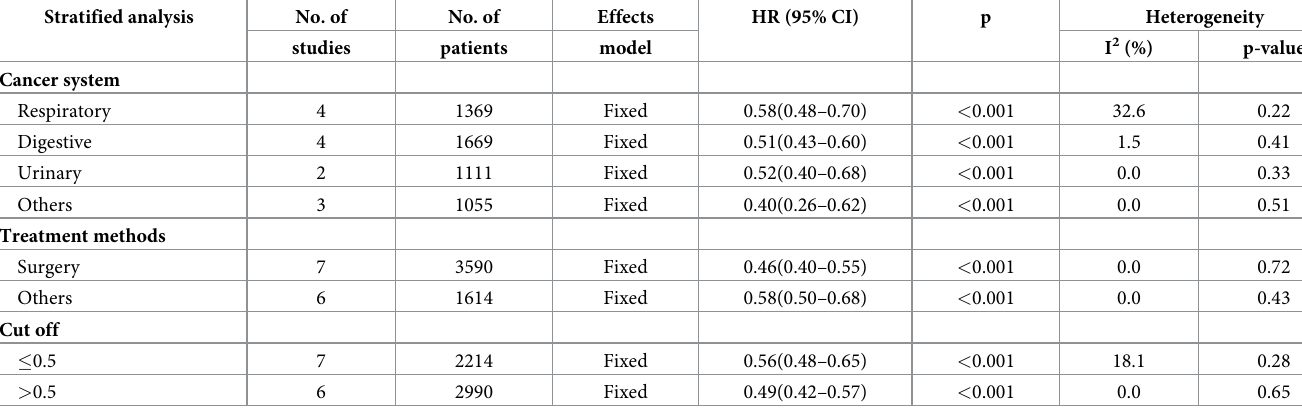
Table 2. Subgroup analysis for OS in the patients with